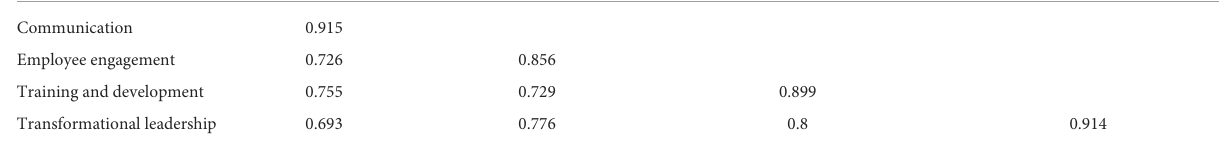
TABLE 3 Discriminant validity using the HTMT ratio.